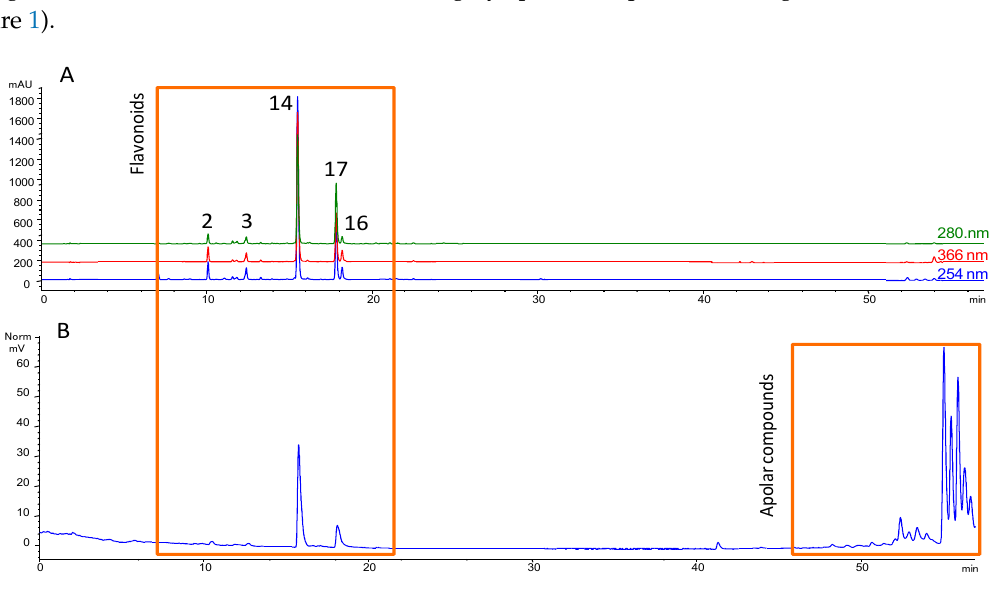
Figure 1. HPLC chromatograms obtained on a Luna C18(2) 100 Å column (150mm × 4.6 mm; 5 µm) at 254, 280 and 366 nm ( A ) and with ELSD ( B ), presenting the major families of compounds identified in RL-3 extract: flavonoids and hydrophobic compounds (peak identification as in Table 2).